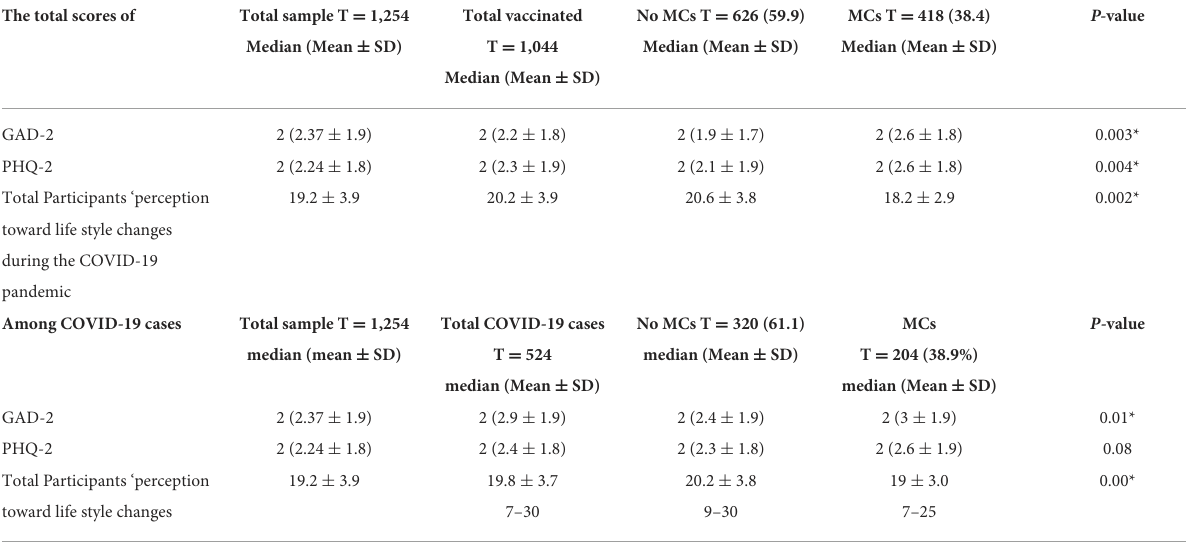
TABLE 2 Total scores of GAD-2, PHQ-2, and participants ‘perception toward life style changes during the COVID-19 pandemic and its relationship with the MCs among the studied groups participants. The total scores